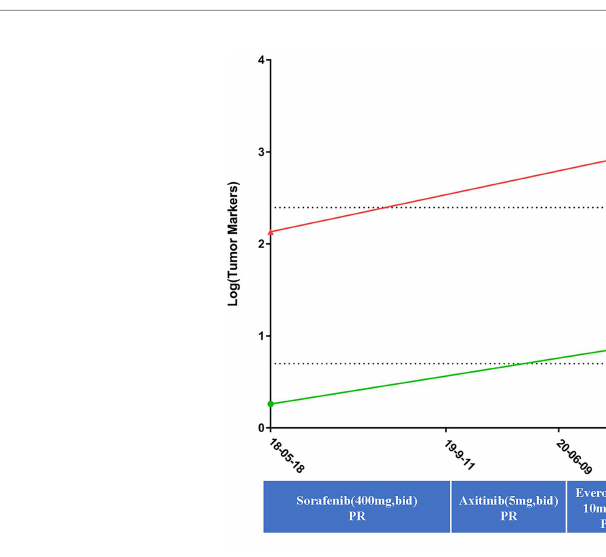
FIGURE 2 | The patient ’ s detailed treatment process and the tumor marker changes. The curve showed that the tumor markers is still in the normal level upon fi rst diagnosis. However, they were already higher than normal when the patient was admitted in our hospital. However, after taking nilapanib, the tumor markers returned to normal again. The blue arrow showed the detailed medication information along the treatment. On the other hand, there is still the lack of speci fi c tumor markers for ccRCC. The changes of LDH and CEA may be inconsistent with changes in the